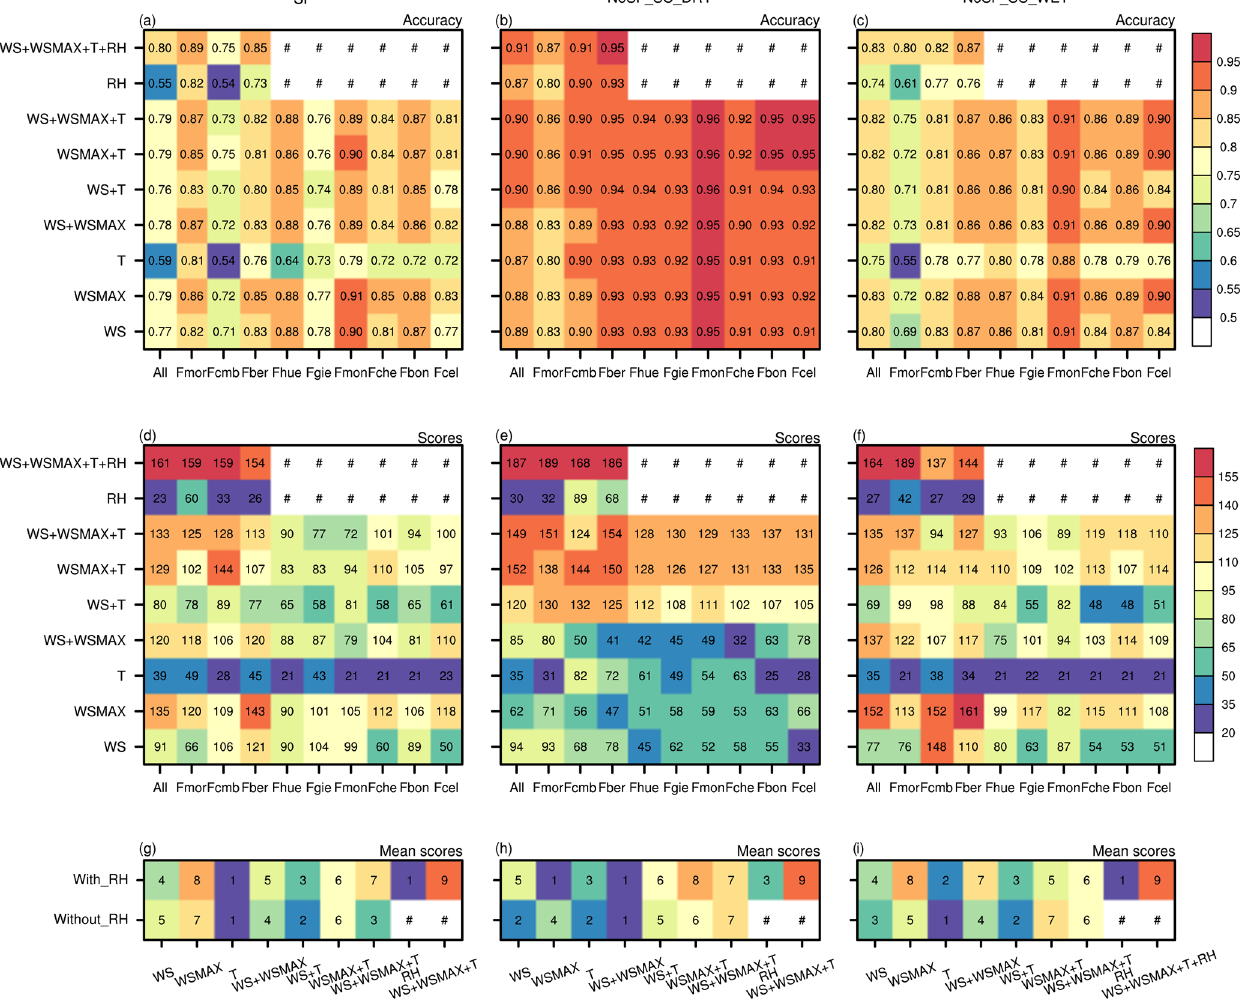
Figure 3. The mean overall accuracy (a–c) and scores (d–f) of the site-independent DTM (All) and the site-specific DTMs trained with different feature variable combinations in snowfall conditions (SF), dry snow cover conditions (NoSF_SC_DRY) and wet snow cover con- ditions (NoSF_SC_WET), and the mean scores of models constructed based on feature variable combinations with and without the RH in- cluded (g–i) . The pound sign (#) indicates that the SSDTM was not constructed using RH. WS is mean wind speed; WSMAX is the maximum wind speed; T is air temperature; RH is relative humidity. Table 4. Performance statistics of decision tree models constructed under different situations with varied ratios for training and testing datasets (ranging from 0.5 to